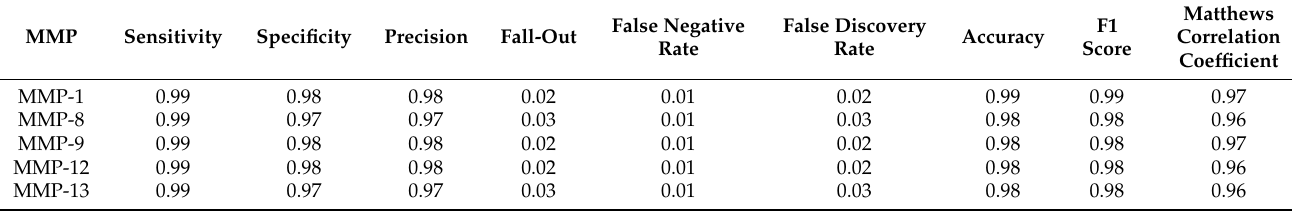
Table 2. Statistical parameters of the RF model validation for each MMP. The values correspond to the means of the 5-fold cross-validation for each